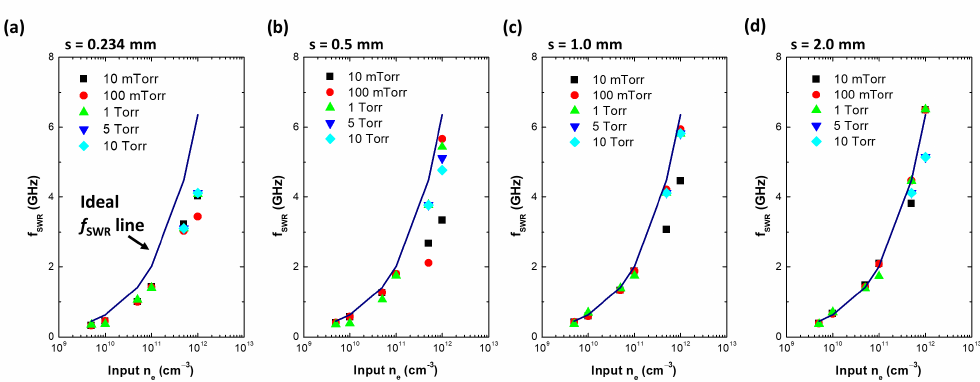
Figure 4. Surface wave resonance frequencies ( f SWR ) with various pressures and input electron densities at sheath widths of ( a ) 0.234 mm, ( b ) 0.5 mm, ( c ) 1.0 mm, and ( d ) 2.0